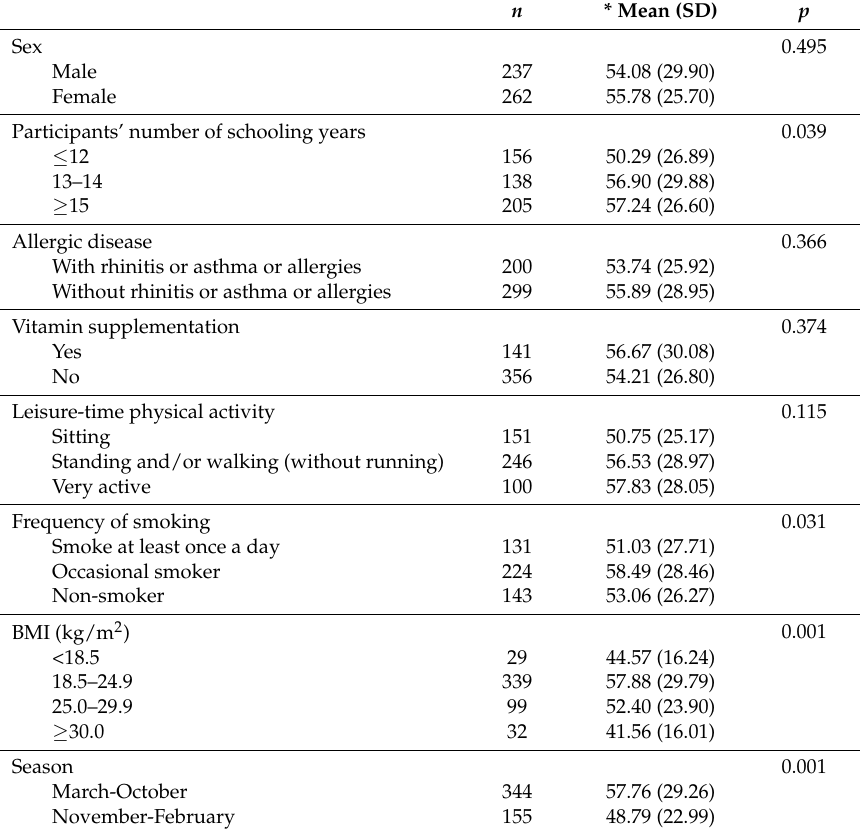
Table 3. Serum 25(OH)D concentration (nmol/L) according to participants’